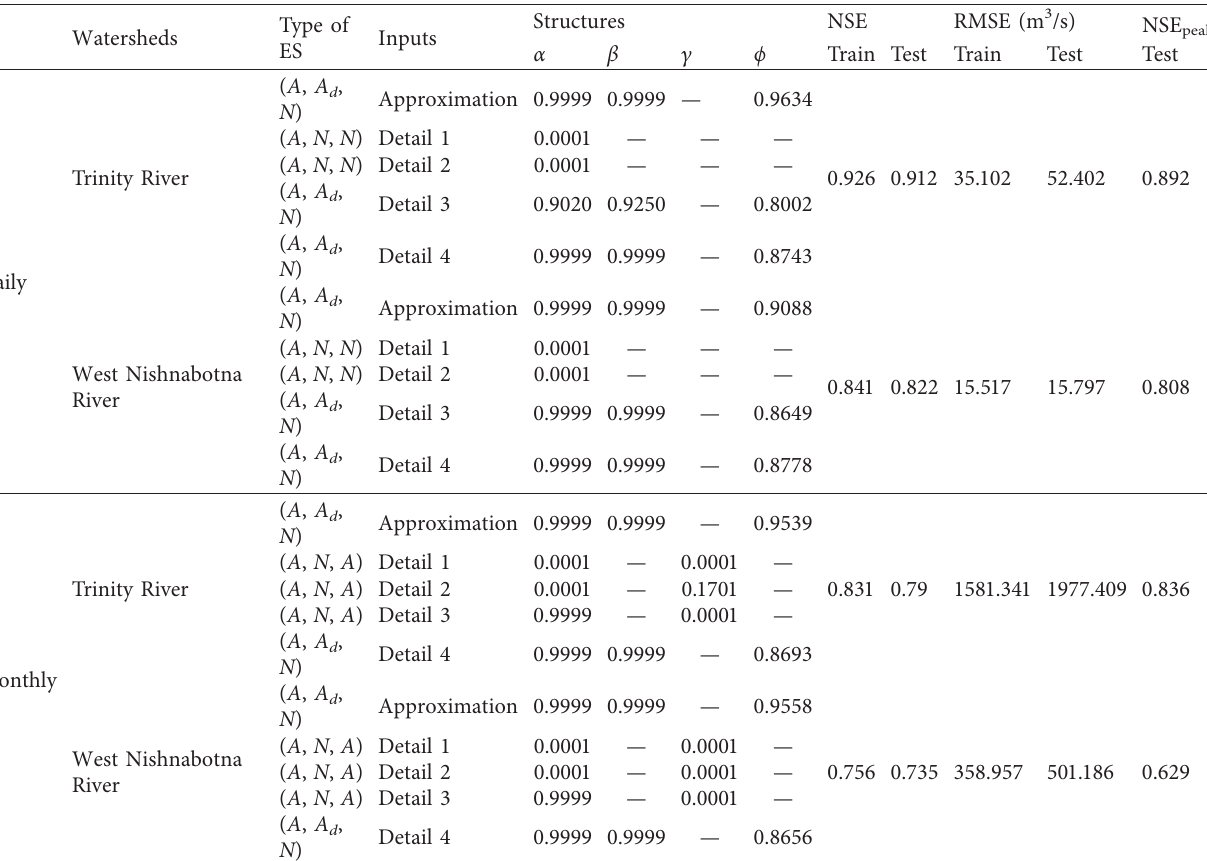
Table 4: Performance results of the WES